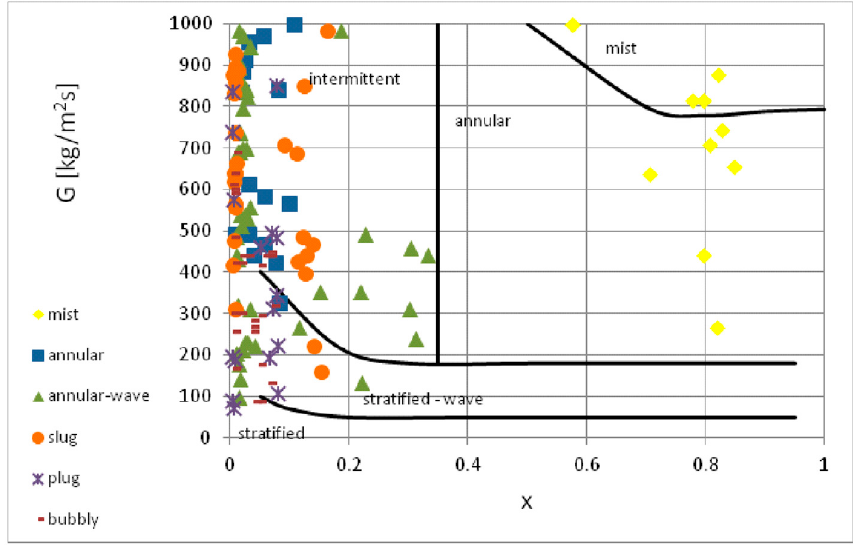
Figure 19. Comparison of the author’s experimental research results with the map of two ‐ phase flow structures according to map of El Hajal et el. [40].